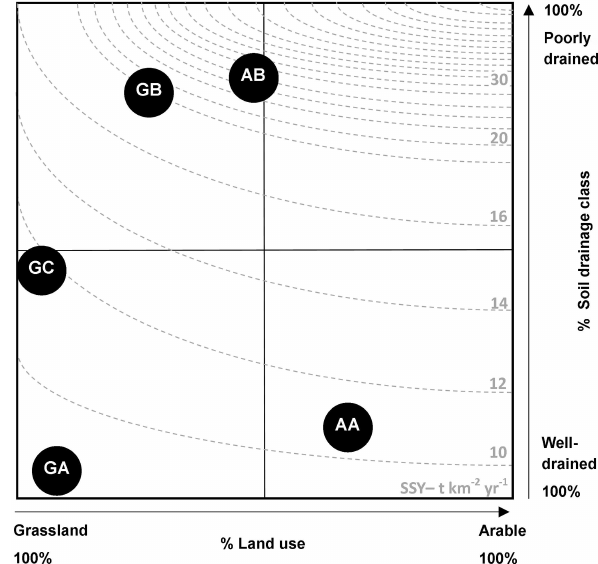
Figure 9. Conceptual diagram of suspended sediment yield as represented by iso-lines according to land use and dominant soil drainage class. Catchment abbreviations: GA – Grassland A; GB – Grassland B; GC – Grassland C; AA – Arable A; AB – Arable B. ing catchments was comparable to the results of Vanmaercke et al. (2012), who reported CV % ranging from 6 to 313 % (median 75 %) in 726 catchments worldwide. The catchment with the lowest inter-annual SSY (11 t km − 2 yr − 1 ), Grass- land A, received the least variable rainfall input and total dis-